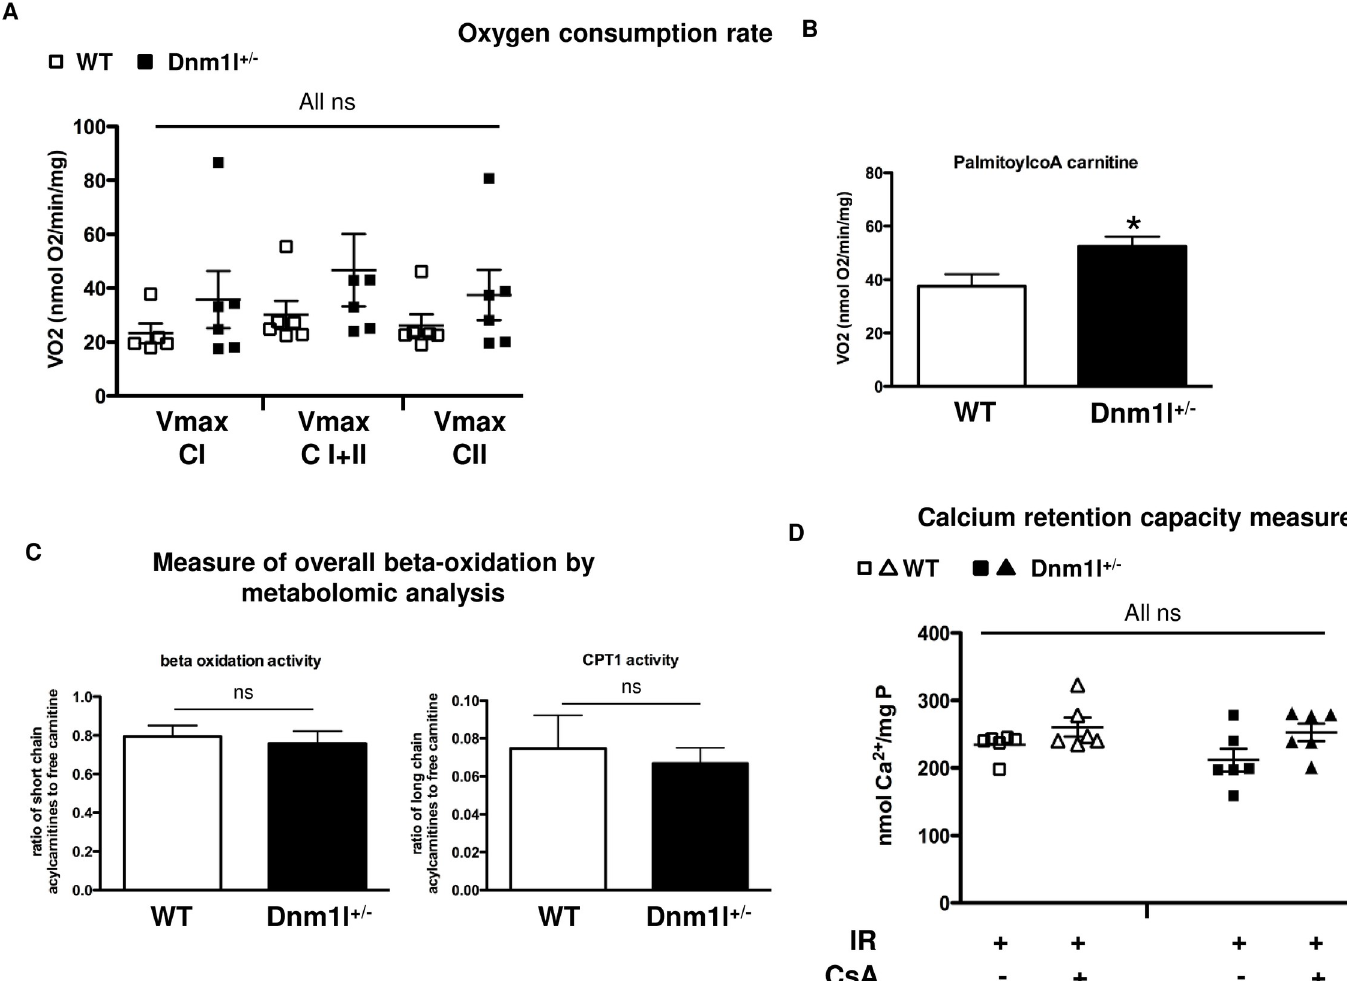
Fig 6. Cardiac energy metabolism and mPTP function. (A) Oxygen consumption rate of permeabilized left ventricular fibers in the presence of 1mM ADP (V max ) with 5 mMmalate and 2.5mM pyruvate (complex I, CI), 10mM succinate (both CI and complex II CI + II), and after complex I inhibition with 2.5 μ M rotenone (CII). Values are expressed as mean ± SEM, (n = 5–6 per group). B) Oxygen consumption rate with 1mM ADP and 2.5mM malate and 40 μ M palmitoylCoA/1mM carnitine. Values are expressed as mean ± SEM, n = 7–8 per group; � p < 0.05. (C) Metabolomic analysis of the cardiac tissue in 3-month-old Dnm1l +/- and control WT mice. n = 10 per group. Left: ratio of short chain acylcarnitines to free carnitine (C2+C3/C0) represents a measure of overall beta-oxidation activity. Right: ratio of long chain acylcarnitines to free carnitine (C16+C18/C0) represents the activity of carnitine palmitoyltransferase 1 (CPT1). (D) CRC was measured in mitochondria isolated from the areas at risk after a 45-min ischemia followed by a 15-min reperfusion. CRC measurement represented the Ca 2+ level required for mitochondrial permeability transition pore (mPTP) opening. Extra-mitochondrial Ca 2+ was detected using Calcium Green TM -5N (Life Technologies). Results were expressed as mean ± SEM nmol Ca 2+ mg protein -1. (n = 6 per group). Mitochondria were isolated from 3-month-old Dnm1l +/- and WT